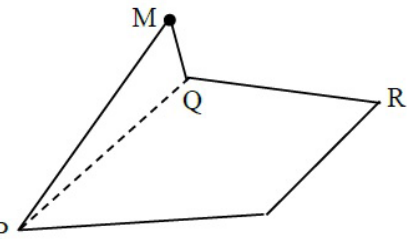
Figure 16: New point is outside PQ.